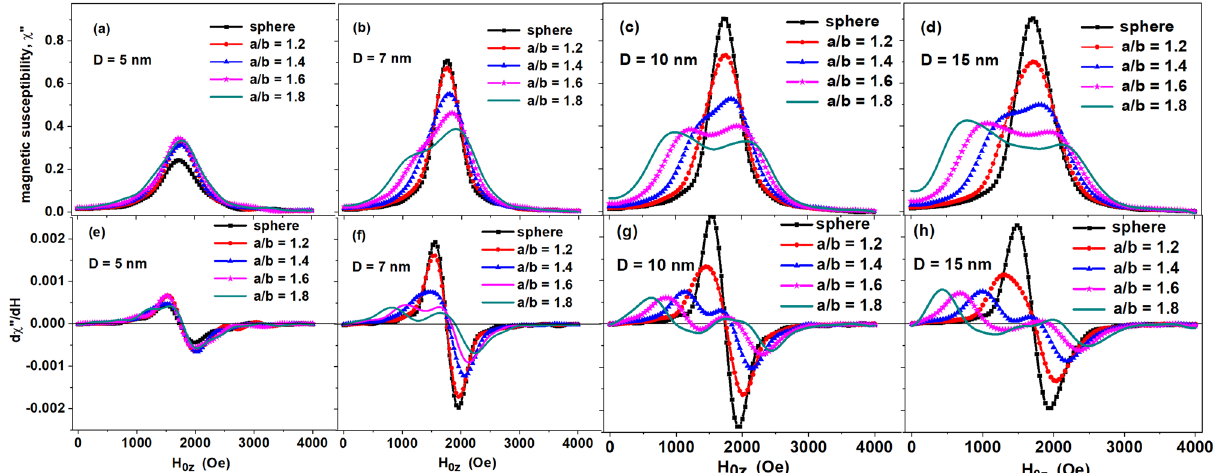
Figure 1. Dependence of the FMR spectrum of a dilute randomly oriented assembly of magnetite nanoparticles on the aspect ratio a / b = 1.0–1.8 for different transverse particle diameters: ( a , e ) D = 5 nm; ( b , f ) D = 7 nm; ( c ,